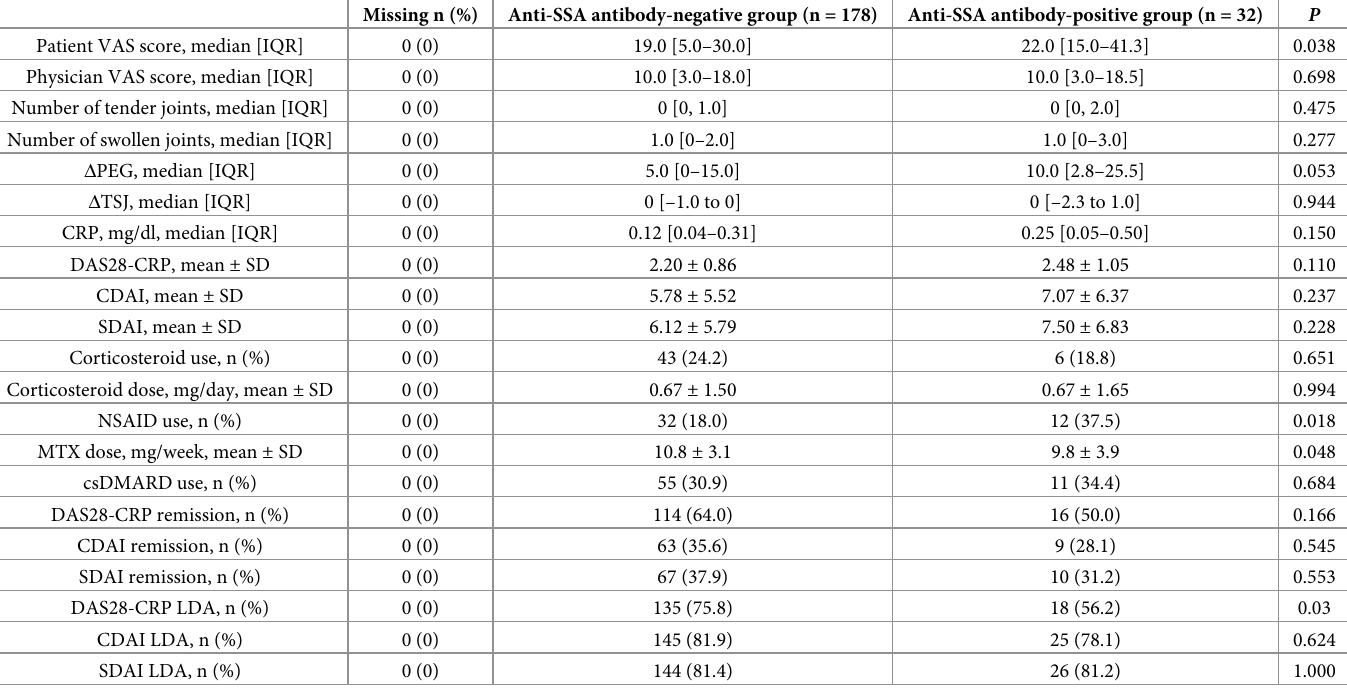
Table 2. Disease activity and medications after 6 months of MTX